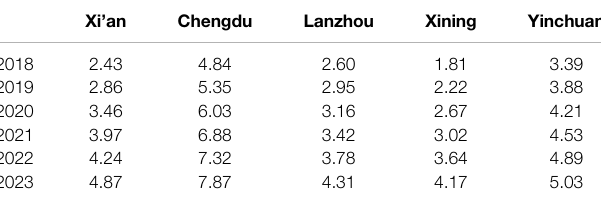
TABLE 9 | Projected trends in urban household gas consumption in the Western Region. Xi ’